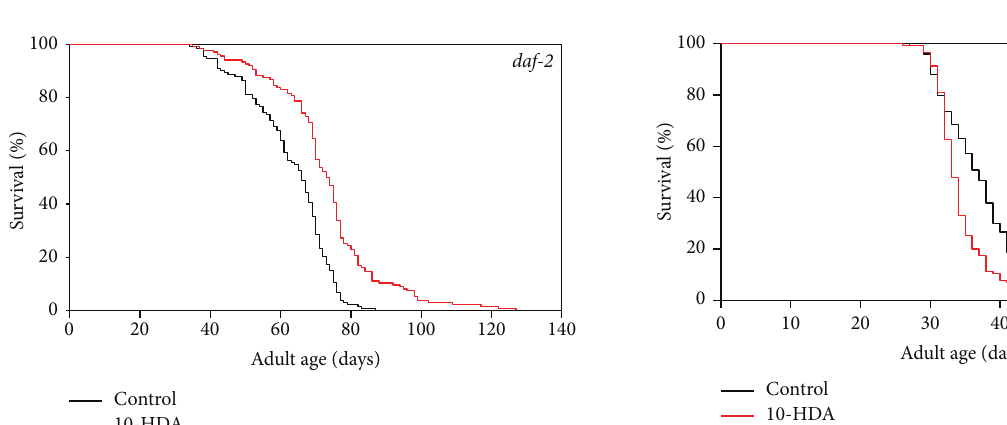
Figure 2: The effect of 10-HDA on the lifespan of the daf-2 mutants. Figure 3: The effect of 10-HDA on the lifespan of the eat-2